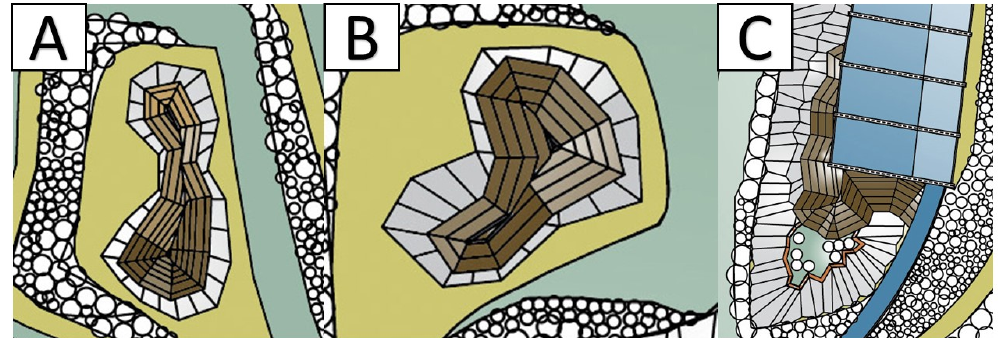
Figure 4. Wooden pergolas on viewpoints (details A,B,C located in Figure 3).